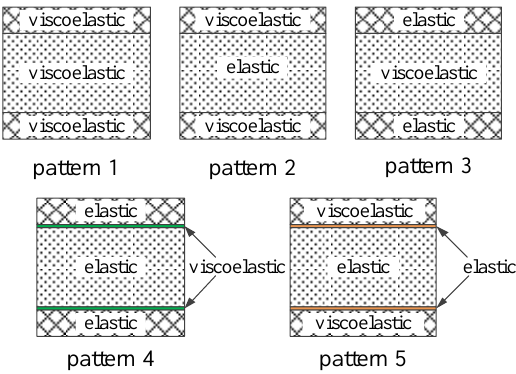
Figure 6. The five patterns of material configuration.